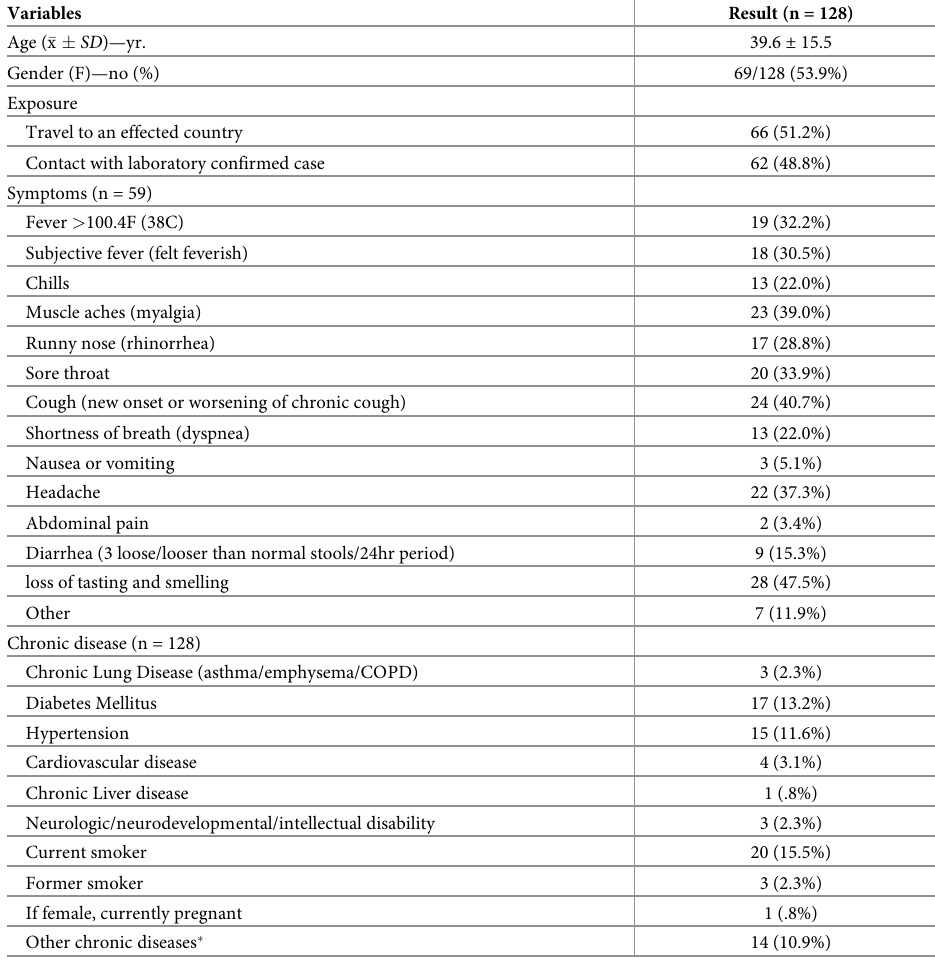
Table 1. Demographic characteristics and reporting symptoms of PCR positive uarantined residents. Variables Result (n =